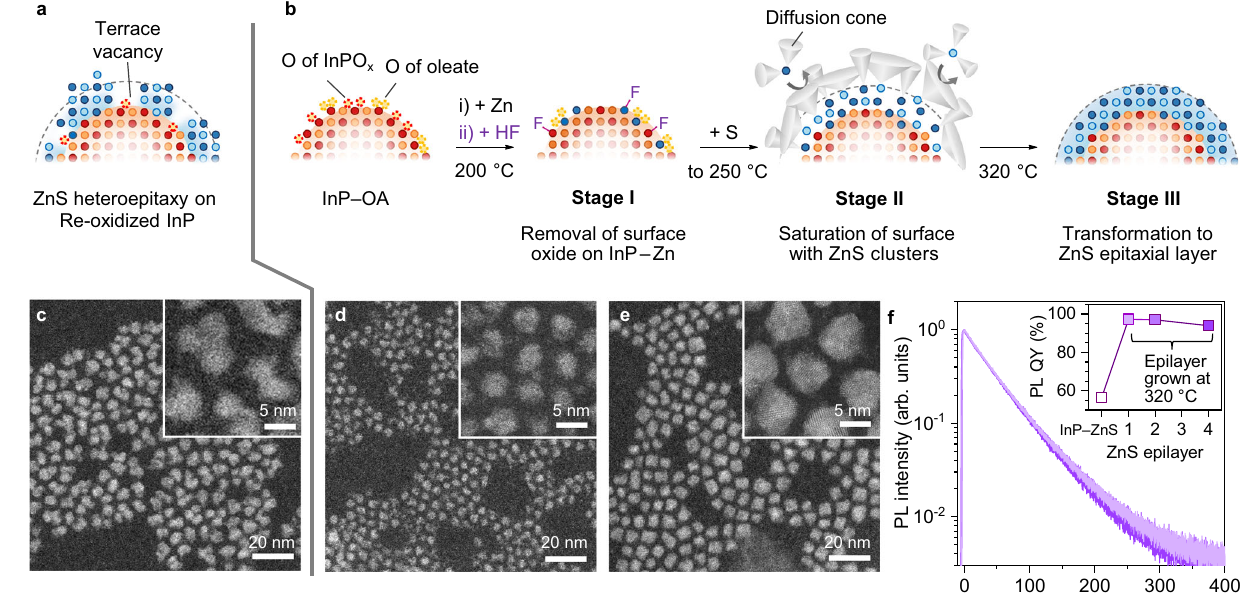
Fig.4|ZnSheteroepitaxyonInPNCsachievingimproveduniformityinasingle epilayer level. a Schematic of conventional ZnS heteroepitaxy performed at high temperatures. Re-oxidation of the surface through Zn(OA) 2 inevitably introduces unreactive surface oxide, in turn, a non-uniform ZnS epilayer is generated. b Proposed fabrication protocol for uniform ZnS epilayer is composed of three stages:StageIforoxideremoval,StageIIforZnSclustersaturation,andStageIIIfor ZnS epitaxial layer formation. In Stage II, alkyl chains of 1 and oleate ligand are visualised using grey diffusion cones. For other cases, the diffusion cone was